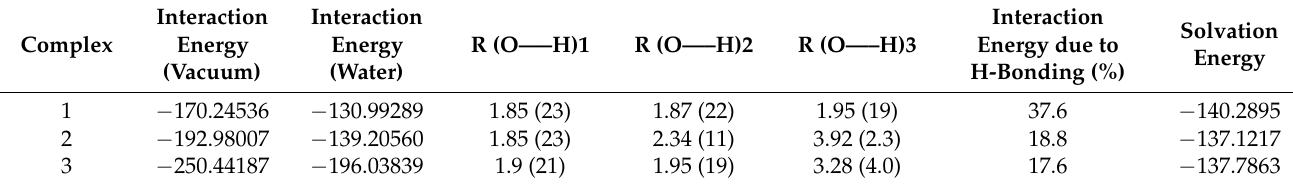
Table 2. Interaction energies (kJ · mol − 1 ) in vacuum and water, length of H-bonds (A) and associated energy (kJ · mol − 1 ), and solvation energy (kJ · mol − 1